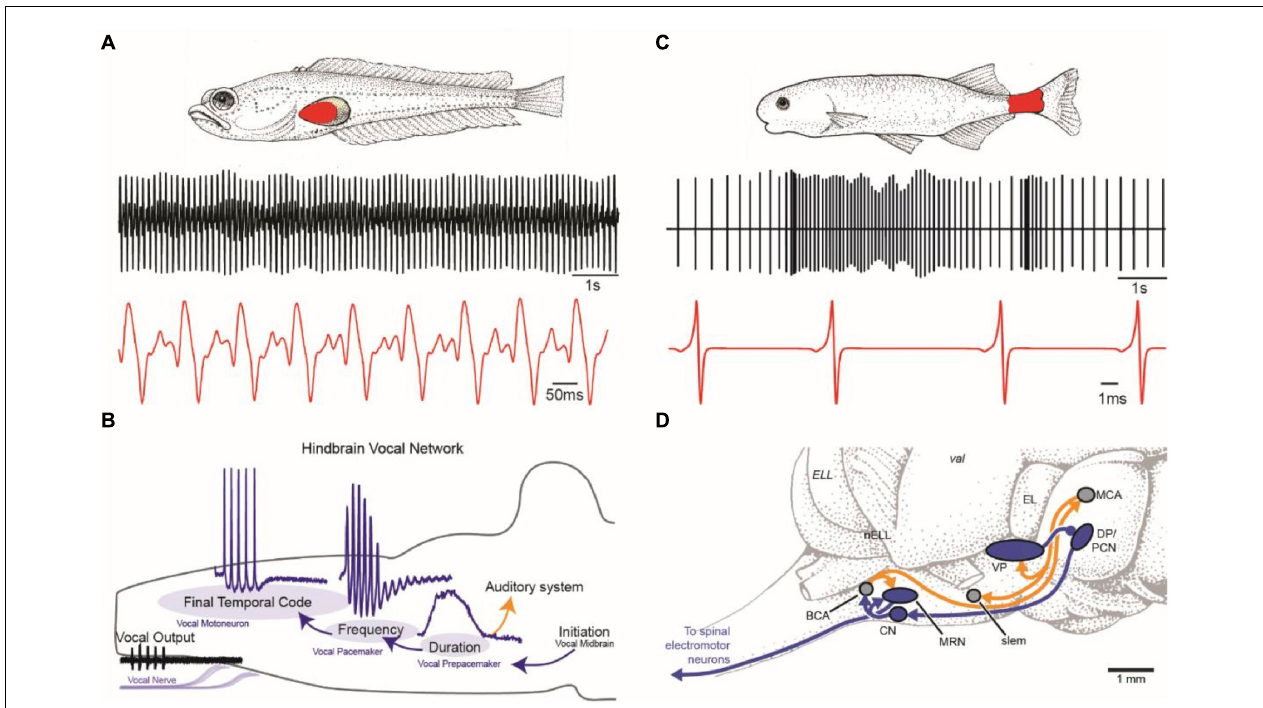
FIGURE 1 | Vocal and weakly electric communication signals and pattern generating neural circuitry. (A) Plainfin midshipman ( Porichthys notatus ) generate sound by contracting paired muscles attached to walls of the swim bladder (red, top). Male advertisement hum with characteristic amplitude modulation shown on two timescales (bottom). (B) Schematic in sagittal plane showing hindbrain vocal pattern generator (blue) and corollary discharge (orange) pathways of midshipman and other toadfishes that includes three topographically separate nuclei, each coding for a different vocal attribute (adapted from Chagnaud et al., 2011). (C) Weakly electric mormyrids use an electric organ located in the caudal peduncle (red, top) to produce a pulsatile electric organ discharge (EOD) shown on two timescales (bottom). (D) Schematic in sagittal plane showing EOD pattern generating circuitry (blue) and corollary discharge pathways (orange) of mormyrid fish. BCA, bulbar command-associated nucleus; CN, command nucleus; DP, dorsal posterior thalamic nucleus; EL, exterolateral nucleus; ELL, electrosensory lateral line lobe; MRN, medullary relay nucleus; MV, medioventral nucleus; MCA, mesencephalic command-associated nucleus; OB, olfactory bulb; PCN, precommand nucleus; slem, sublemniscal nucleus; tel, telencephalon; val, valvula of the cerebellum; VP, ventroposterior nucleus. (Panels C and D adapted from Baker et al., 2013 with permission from the Journal of Experimental